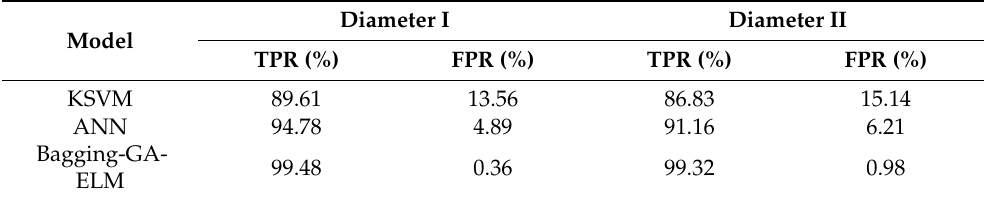
Table 7. The identification performance of quality problems under different background noise.